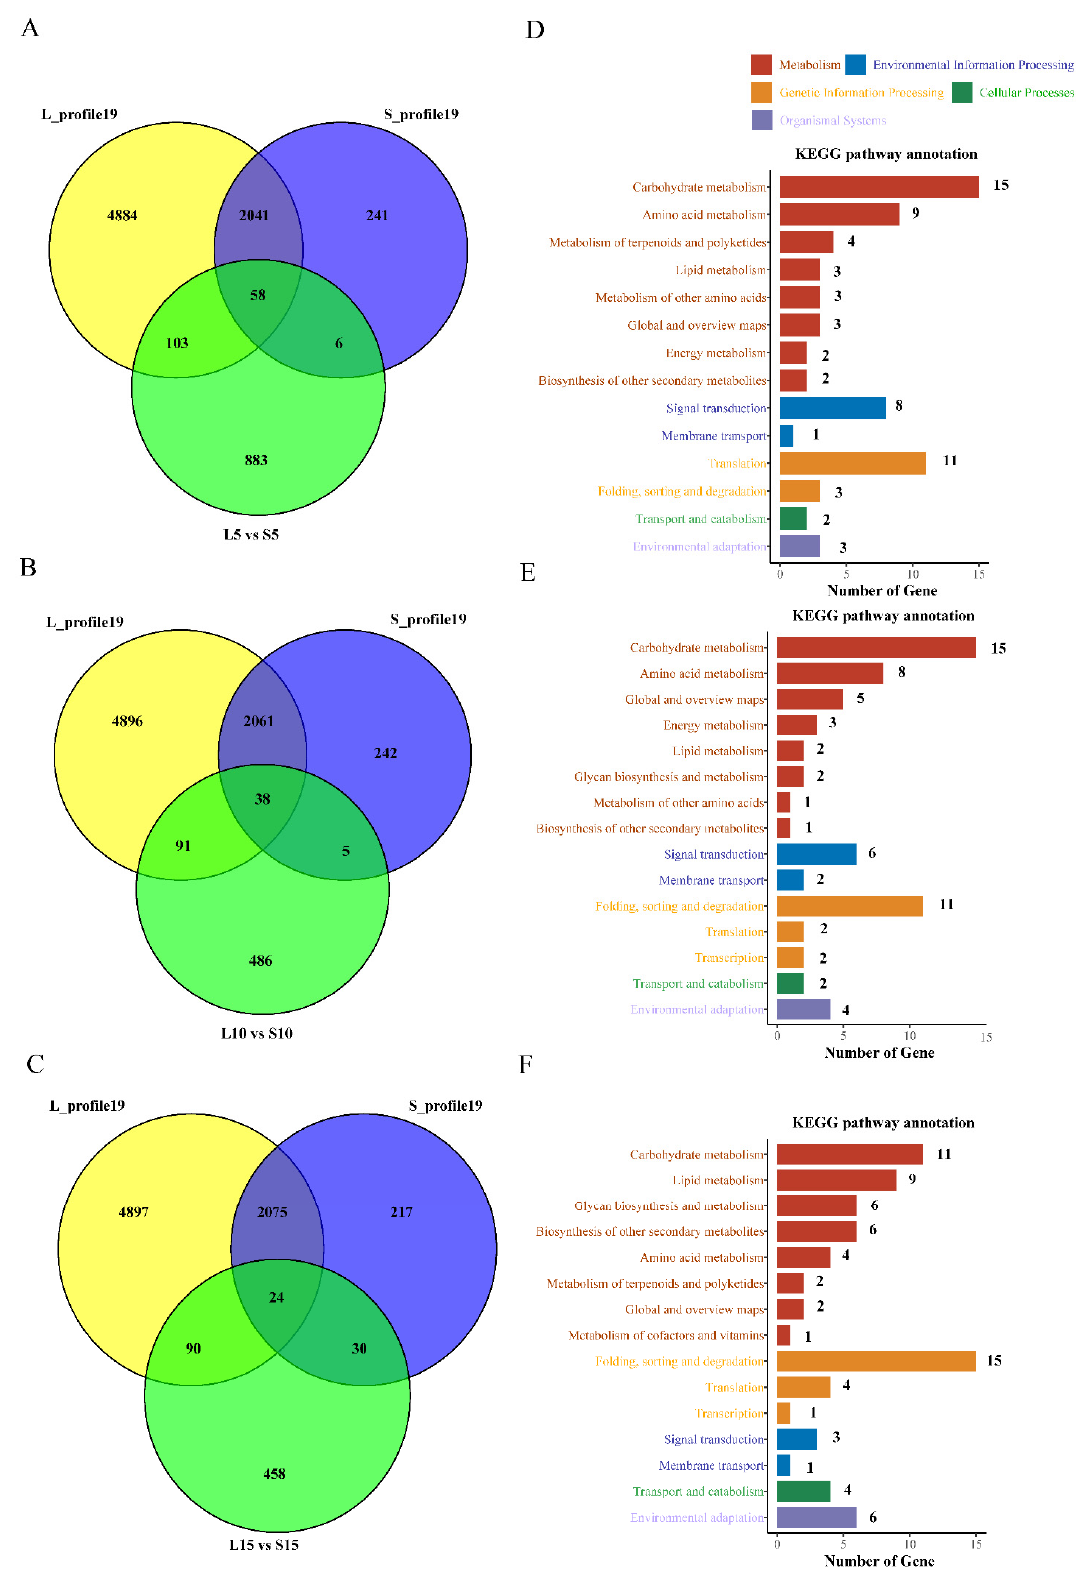
Figure 5. Venn diagram and KEGG pathway annotation of DEGs. ( A ) Number of DEGs shared by L and S in profile 19 and 5 DPA comparisons. ( B ) Number of DEGs shared by L and S in profile 19 and 10 DPA comparisons. ( C ) Number of DEGs shared by L and S in profile 19 and 15 DPA comparison. ( D ) KEGG pathway annotations for the 167 DEGs in A. ( E ) KEGG pathway annotations for the 138 DEGs in B. ( F ) KEGG pathway annotations for the 144 DEGs in